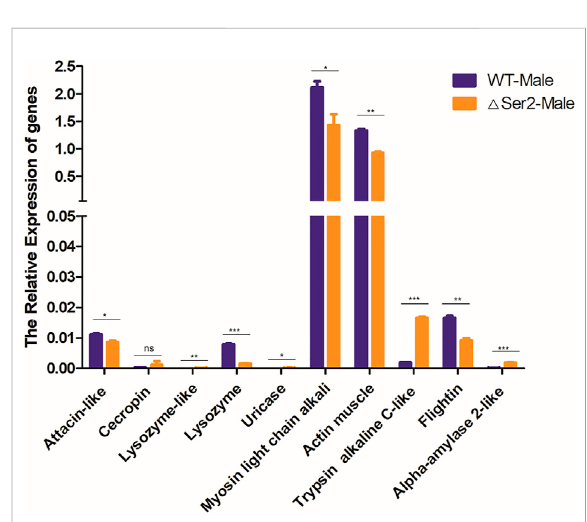
FIGURE 5 Mutation of the SlSer2 gene affects relative expression of genes involved in adult stage. Levels of indicated mRNAs in SlSer2 mutants relative to wild-type levels. Three individual biological replicates of real-time PCR were performed. The asterisks (** or ***) indicate the signi fi cant differences ( p < 0.01 or p < 0.001, respectively) compared with the wild type adult with a two-tailed t